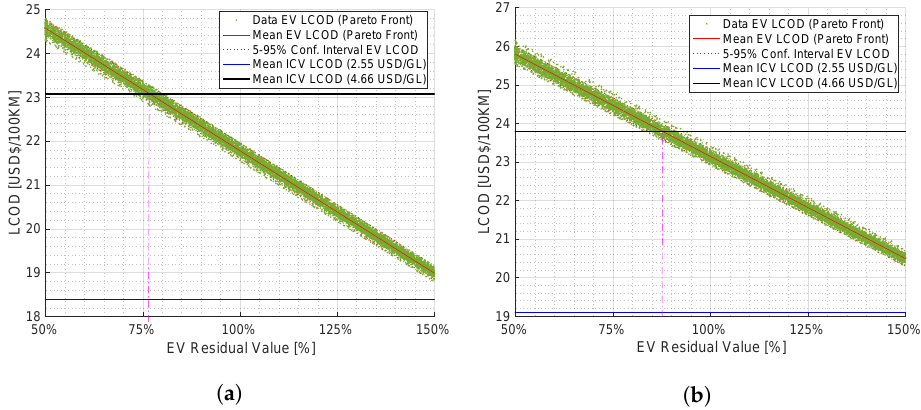
Figure 4. Sensibility Analysis with respect to EV Residual Value. ( a ) Case A ( r = 10%). ( b ) Case B ( r = 12%).